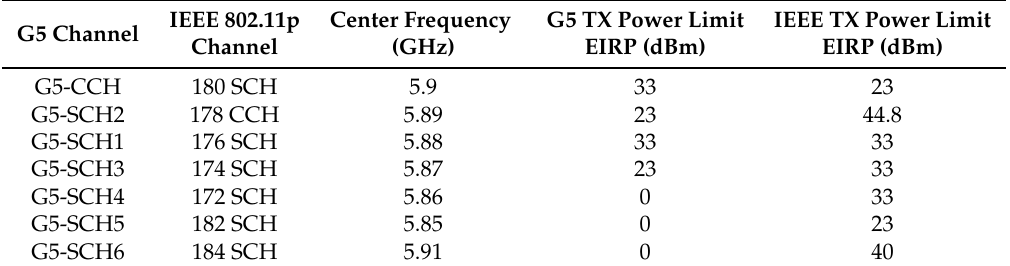
Table 2. Channel allocation for ITS-G5 in Europe and IEEE 802.11p in the